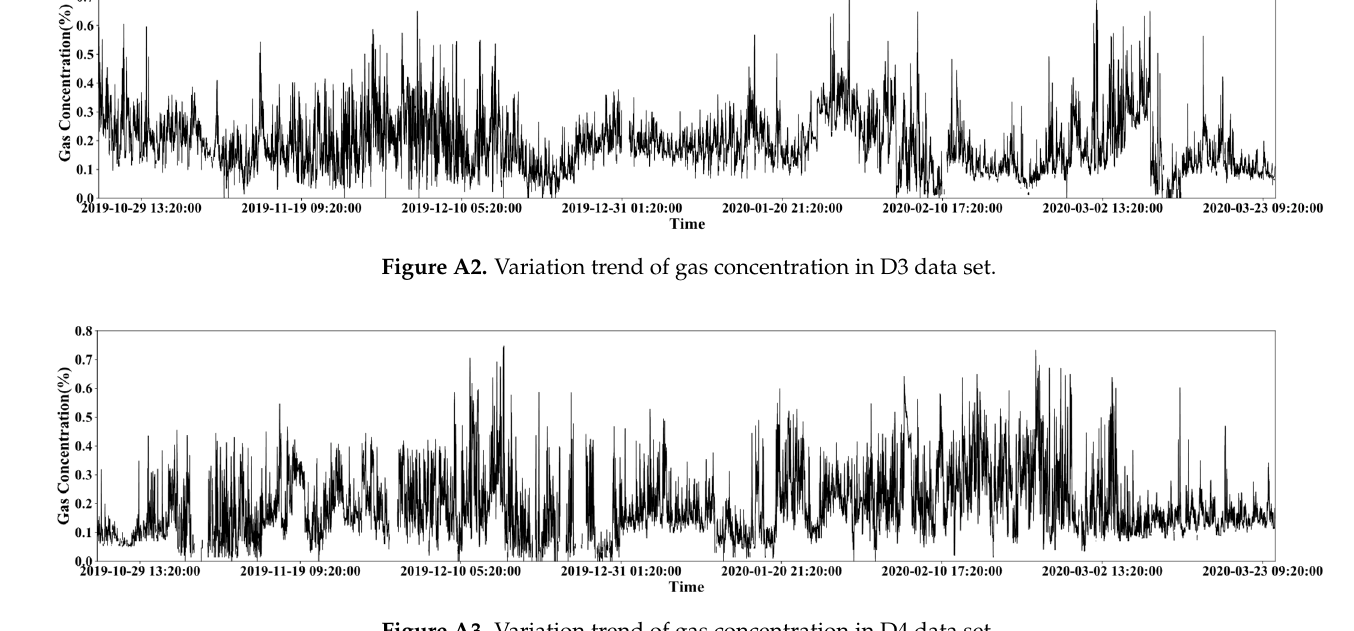
Figure A3. Variation trend of gas concentration in D4 data set.